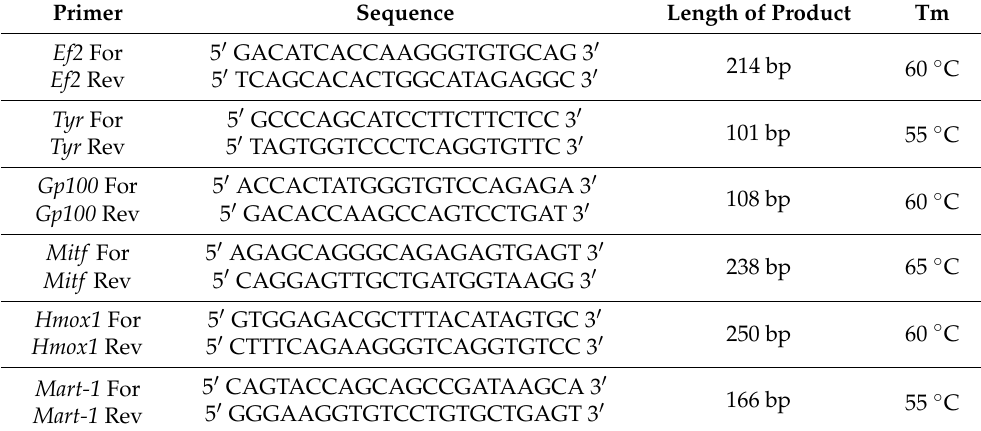
Table 2. Sequences of primers used in the